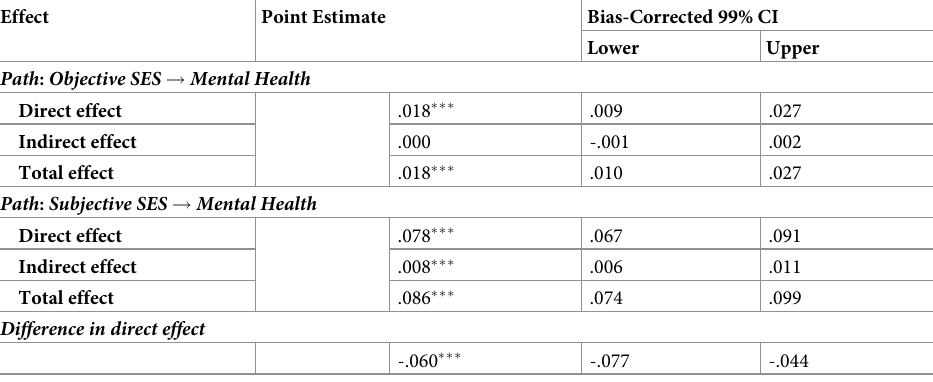
Table 4. Unstandardized direct, indirect, and total effects of the structural equation